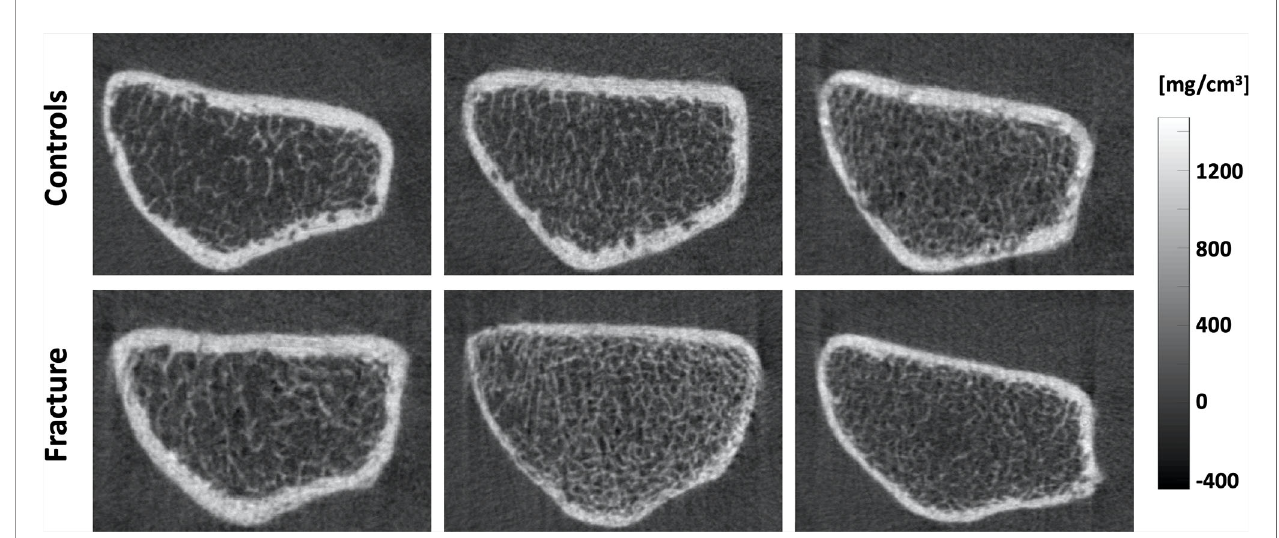
FIGURE 1 | Representative axial cross-sections of HR-pQCT images of the distal radius for three controls (top) and three fracture cases